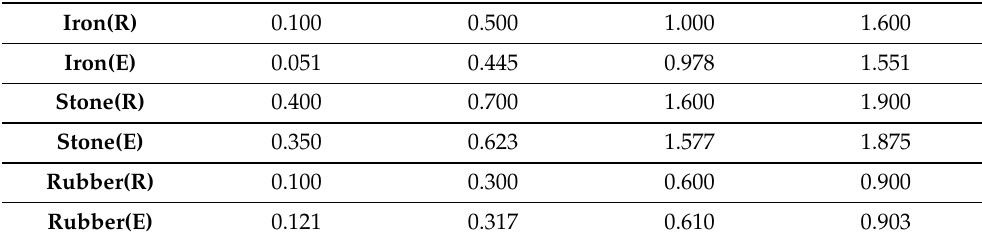
Table 11. Real and estimated depths of underwater targets of different materials. ‘ R ’ denotes ‘Real’, ‘ E ’ denotes